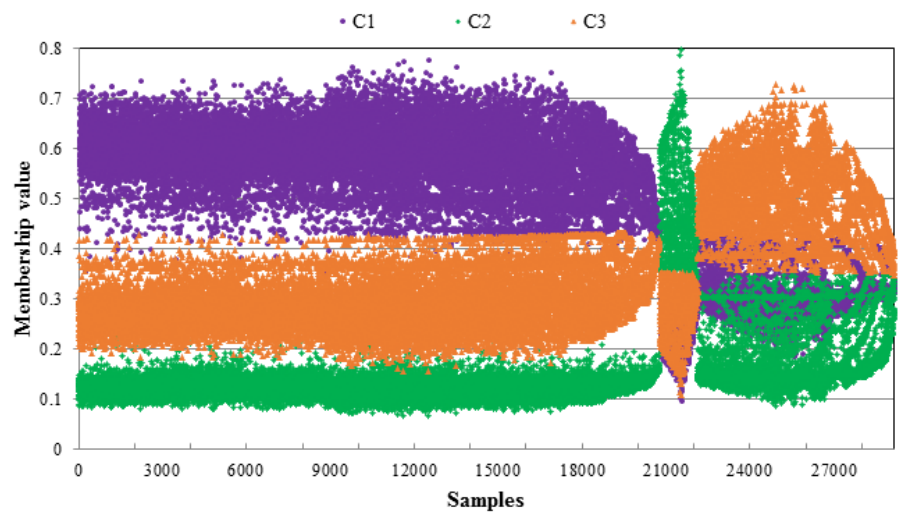
Figure 3. The membership value of each sample.